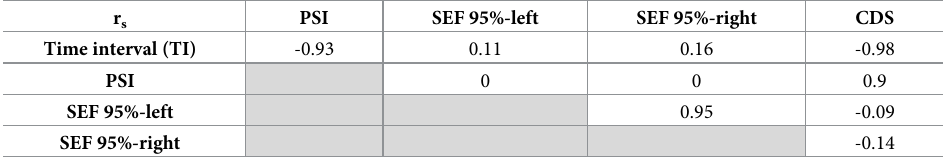
Table 3. Spearman correlation coefficients (r s ) measured for the relationship between propofol dose [correspond- ing to time intervals (TI)], patient state index (PSI), spectral edge frequency 95% (SEF 95%)-left and -right and clinical depth of anaesthesia score (CDS) in pigs under propofol